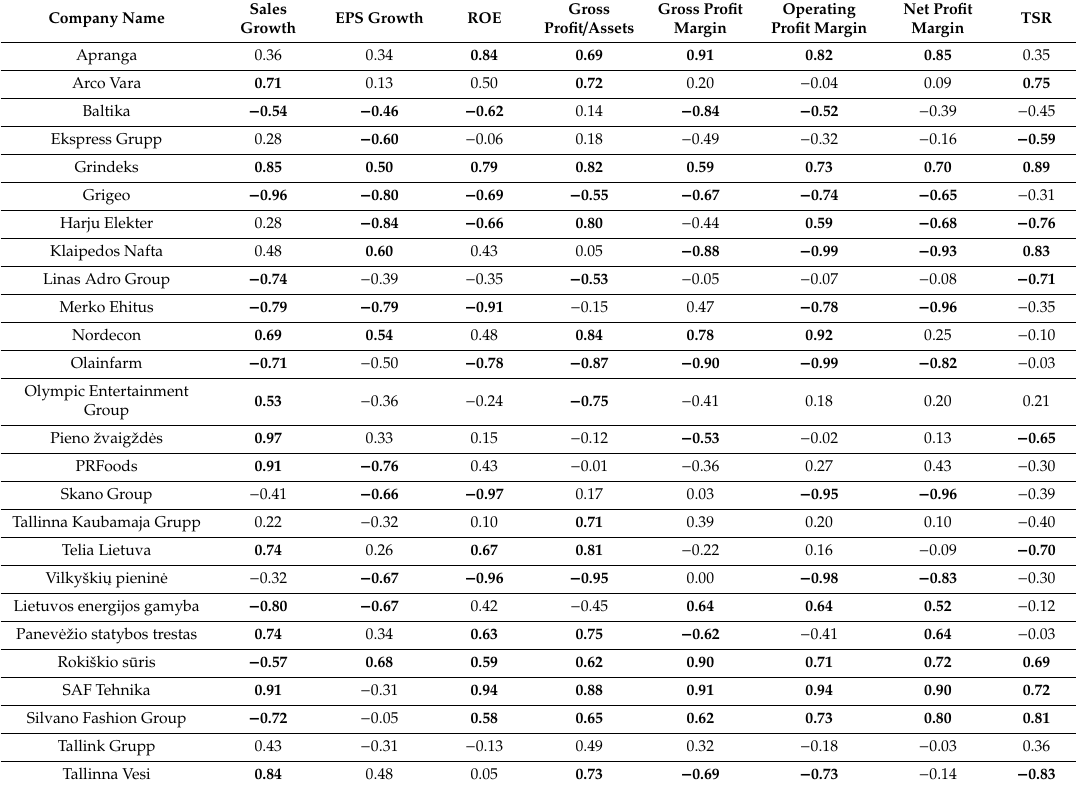
Table 2. Correlation coe ffi cients of corporate digital maturity and financial indicators. TSR, total shareholders’